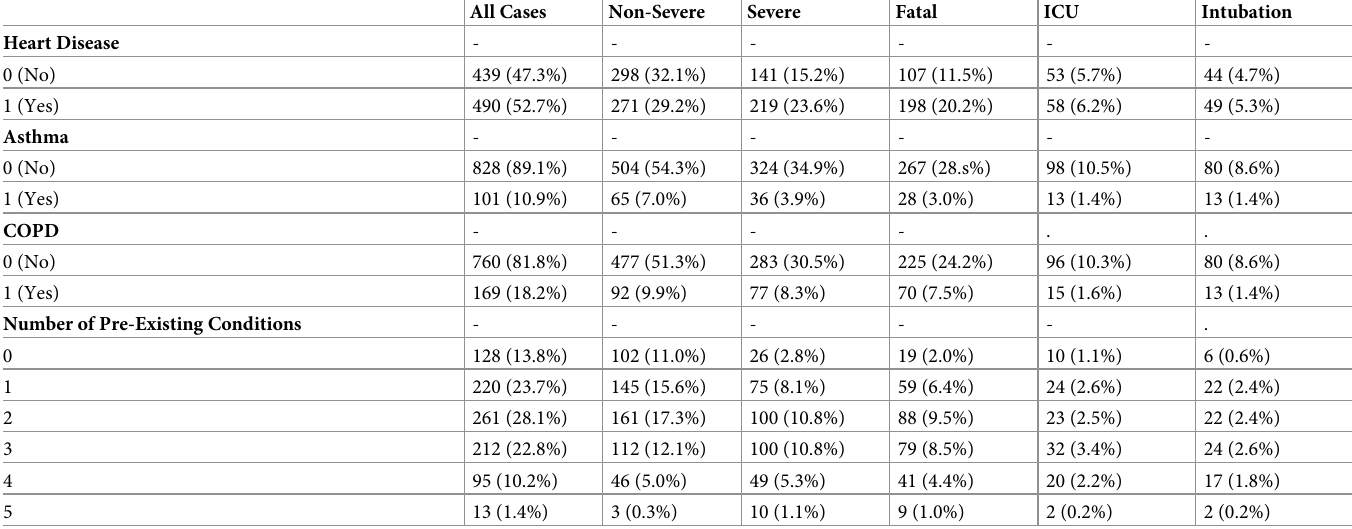
Summary table breaking down key variables from the joint dataset for all, non-severe and severe cases, respectively. Data presented is either the number of cases and percentage of all cases for categorical variables, or the median with the interquartile range for continuous variables.